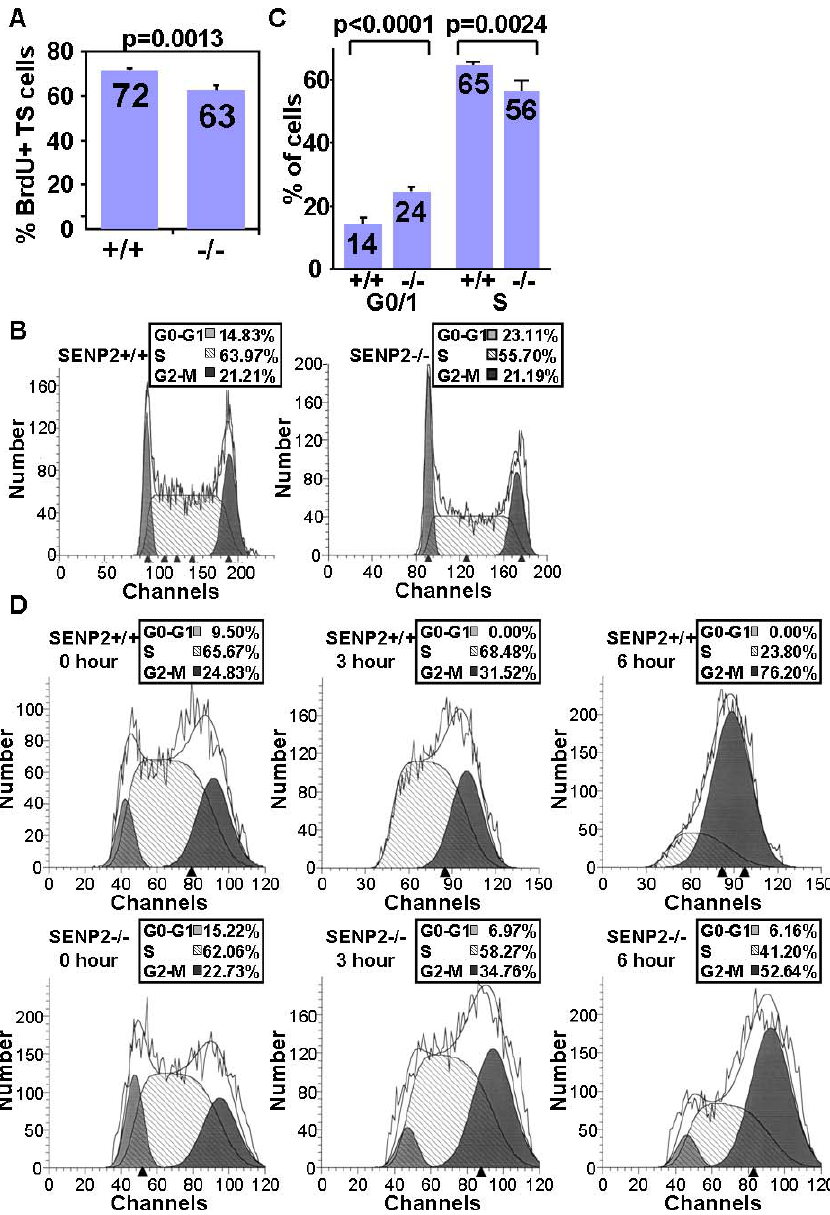
Figure 7. SENP2 Is Critical for the G1–S Transition of Mitotic Division in TS Cells (A) BrdU labeling for 1 h measured the proliferation rate of the SENP2 þ / þ and SENP2 –/– TS cells in vitro. The graph shows the average percentages of the BrdU-positive cells in three independent experiments ( p ¼ 0.0013, n ¼ 3). (B,C) Flow cytometric analysis of the PI-stained SENP2 þ / þ and SENP2 –/– TS cells to determine their cell cycle profiles. The result shown in (B) is a representative of four independent experiments, and the graph in (C) shows the average percentage of the G0–G1 and S populations ( n ¼ 4). A consistent increase in the G0–G1 population ( p , 0.0001) and decrease in the S population ( p ¼ 0.0024) was detected in the SENP2 mutants. (D) The SENP2 þ / þ and SENP2 –/– TS cells were treated with nocodazole for 0, 3 and 6 h as indicated. Flow cytometric analyses showed that there was a delay in synchronizing the SENP2 –/– cells upon the nocodazole treatment.